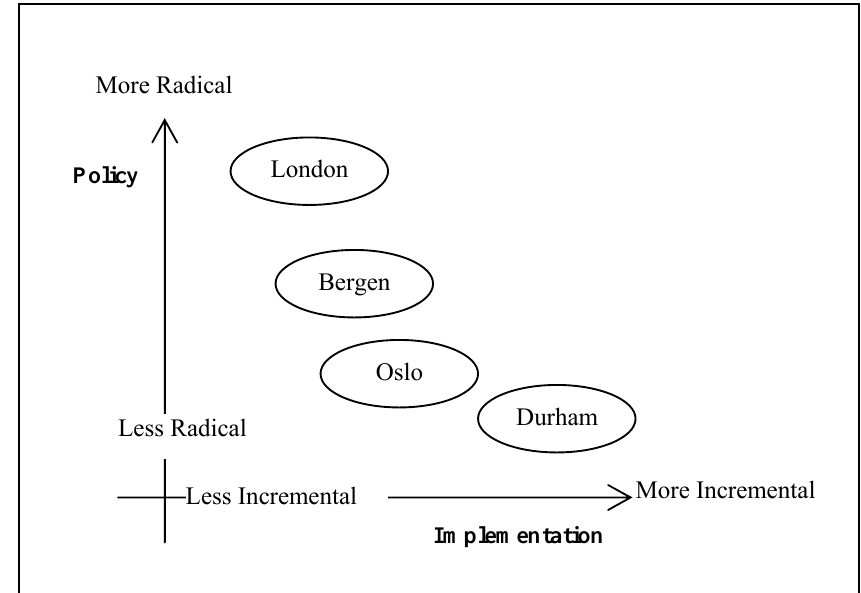
Figure 3. Incremental versus radical in the four